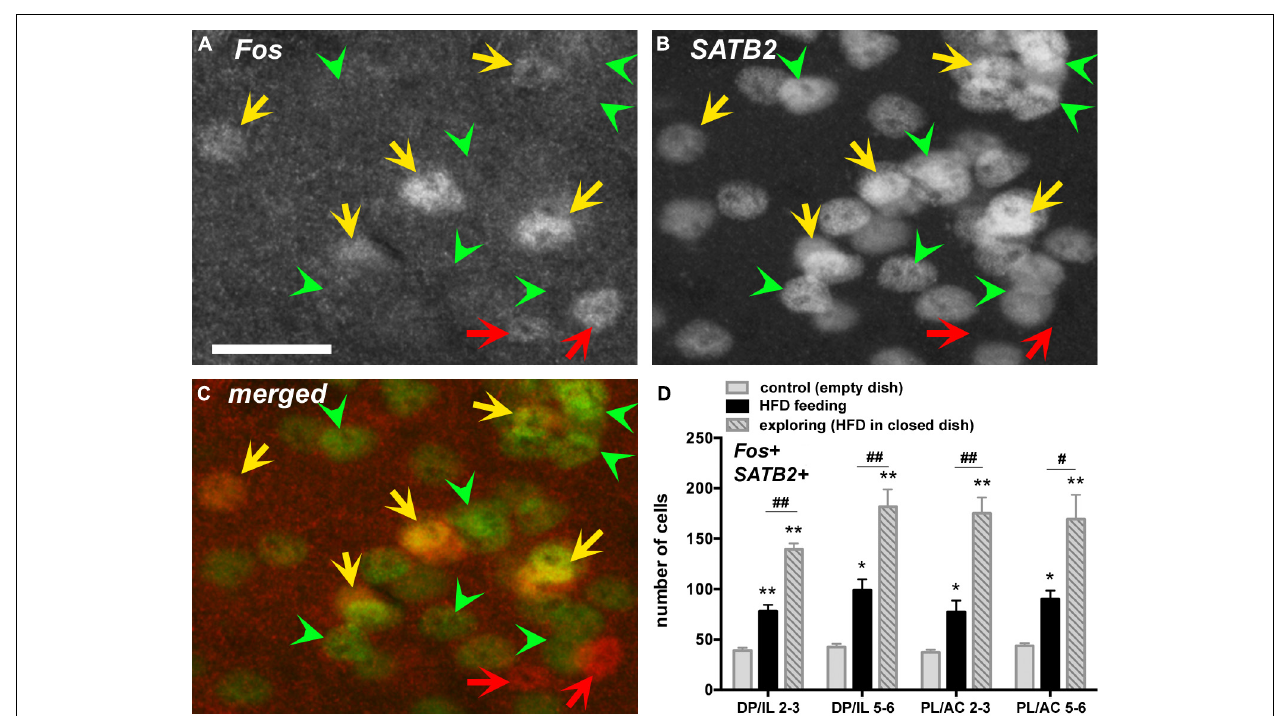
Some of the SATB2-labeled cells lacking c-Fos labeling are indicated with green arrowheads. (D) The number of double-labeled cells (SATB2-positive neurons that show Fos labeling) increased throughout the mPFC in the HFD feeding group, and even more so in the exploratory group in pursuit of the HFD ( n = 5/group). * p < 0.05, ** p < 0.005, differences with respect to the control group. # p < 0.05, ## p < 0.005, differences between feeding and exploring groups. Scale bar in A = 25 μ m, and also applies to B , C .